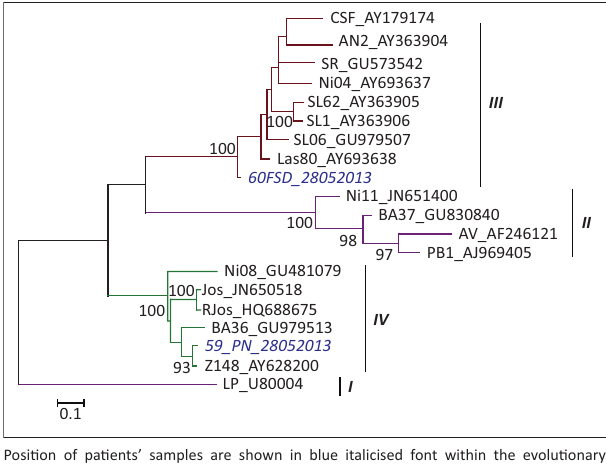
Position of patients’ samples are shown in blue italicised font within the evolutionary lineages (labelled I through IV) of the Lassa virus. The neighbour-joining and bootstrapping (1000 replicates) algorithms were computed by the MEGA 5 software package. FIGURE 3: Phylogenetic relationship between the nucleotide sequences of reported Lassa virus strains and that of the two